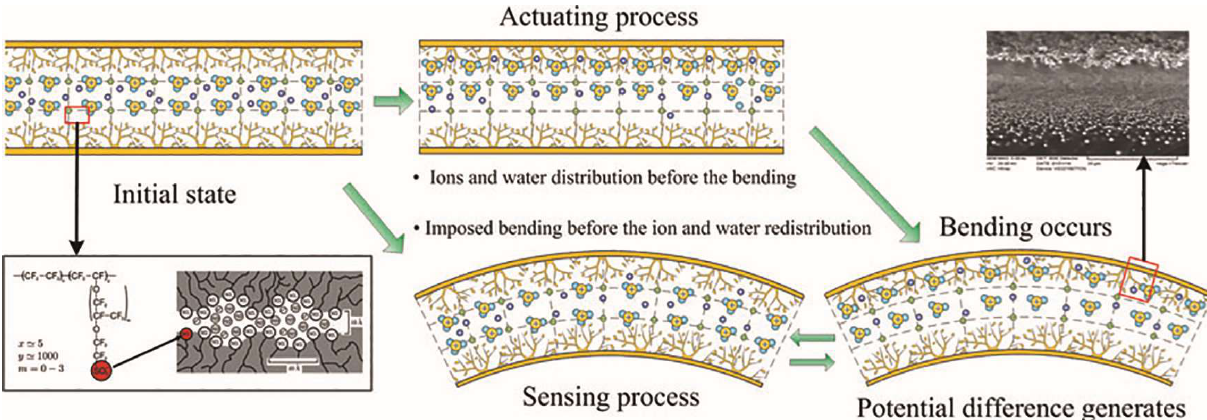
Figure 2. Schematic diagram of IPMC driving mechanism [34].